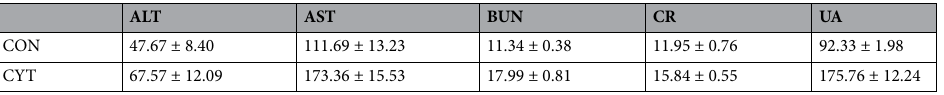
Table 2. Liver and kidney toxicity indexes of CYT treatment group and control group. The normal reference range of each index: alanine aminotransferase (ALT) (10.06–96.4U/L), aspartate aminotransferase (AST)